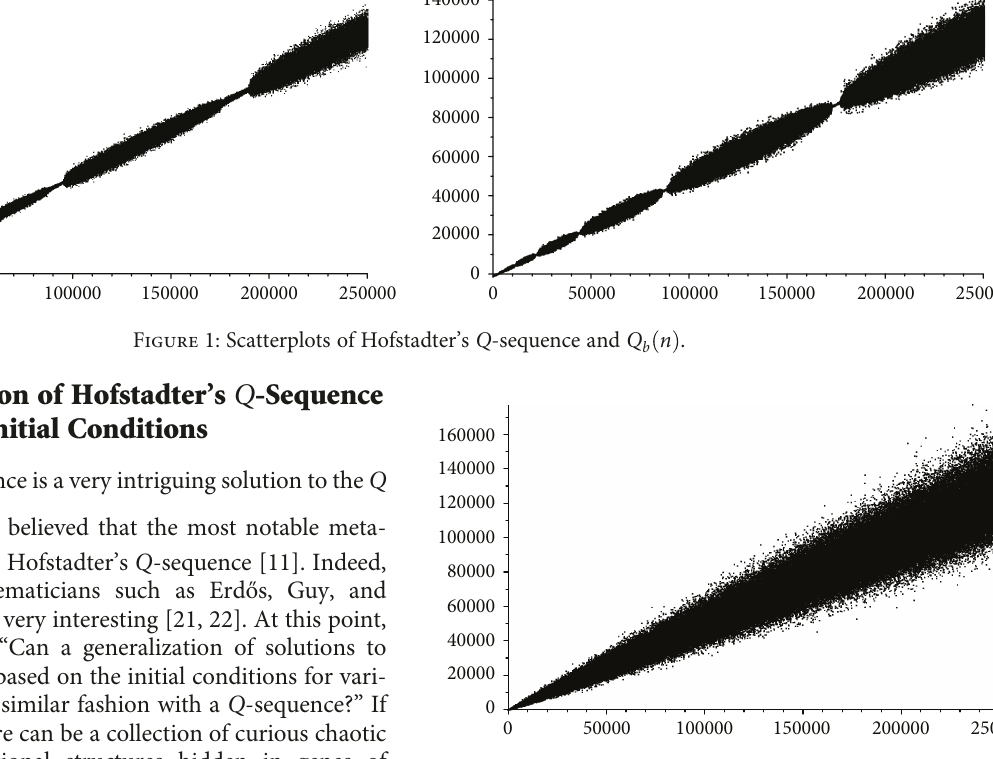
Figure 2: Scatterplot of Q